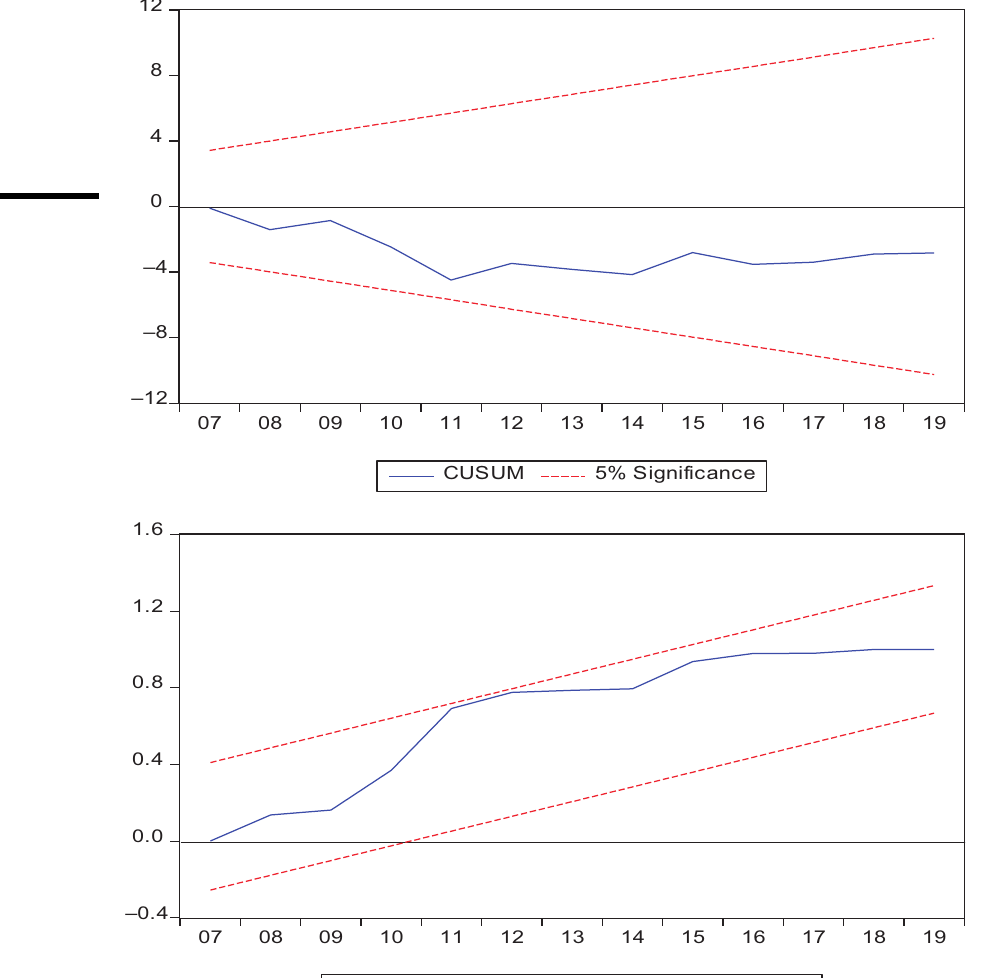
Figure 1. Parameters stability